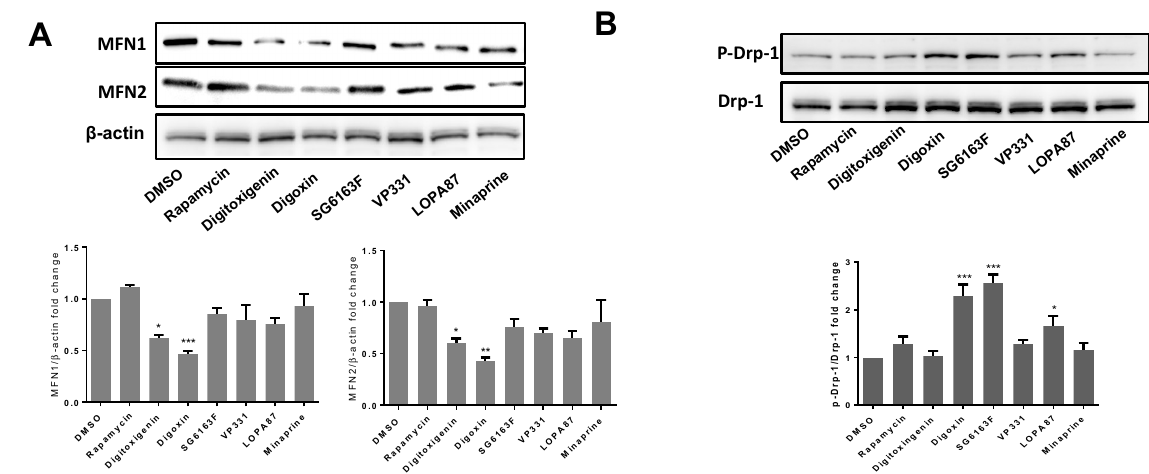
Figure 7. Effects of compounds on the expression of proteins of the mitochondria fusion/fission machinery. ( A ) Following RNVCs incubation with 1 µM of indicated compounds, expression was analyzed by Western blot. The intensities of MFN1 and MFN2 bands were normalized to β -actin. ( B ) Drp-1 and p -Drp-1 expressions in treated RNVCs were analyzed by Western blot and their ratio quantified. Experiments were repeated 3 times. Representative Western blot images and quantification of three independent experiments are presented as mean ± SEM with one-way ANOVA, Sidak’s multiple comparisons test. *, p < 0.05, **, p < 0.01, ***, p < 0.001 vs. DMSO. In digoxin and SG6163F- treated cells, numerous short and round mitochondria can be observed compared to 0.1% DMSO-treated cells (controls), which have long and thin mitochondria (Figure 8). Thus, transmission electron microscopy confirms that mitochondria are smaller in H9c2 cells treated with 10 µM SG6163F and 1 µM digoxin in comparison to cells treated with DMSO or 1 µM SG6163F.